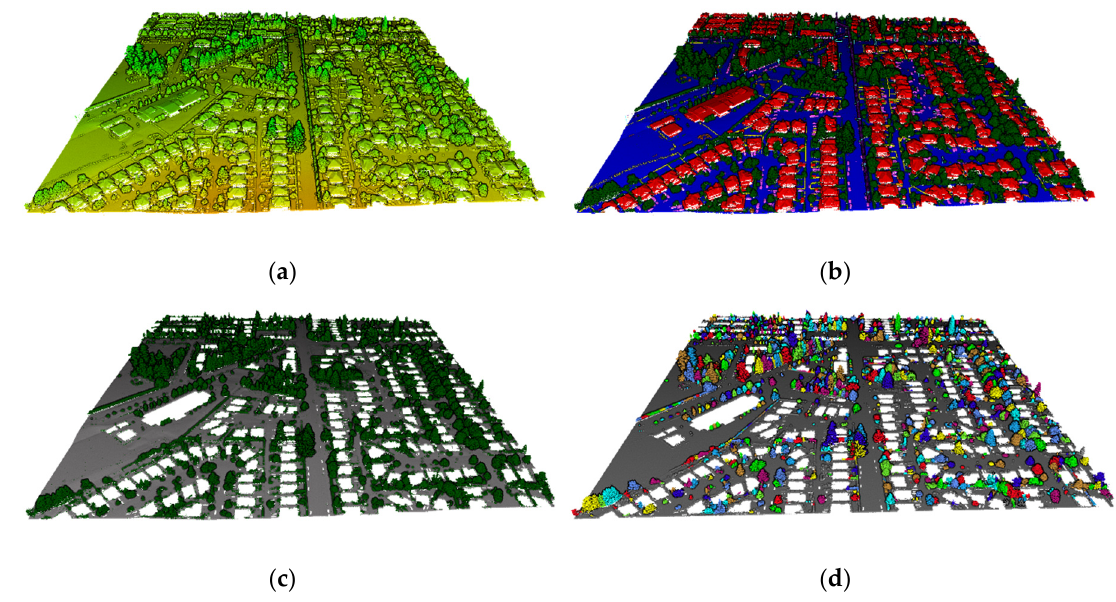
Figure 13. Detailed results from selected area 1 of DALES dataset. ( a ) the original point clouds; ( b ) the classification result; ( c ) the roadside trees extraction; ( d ) the roadside trees segmentation.